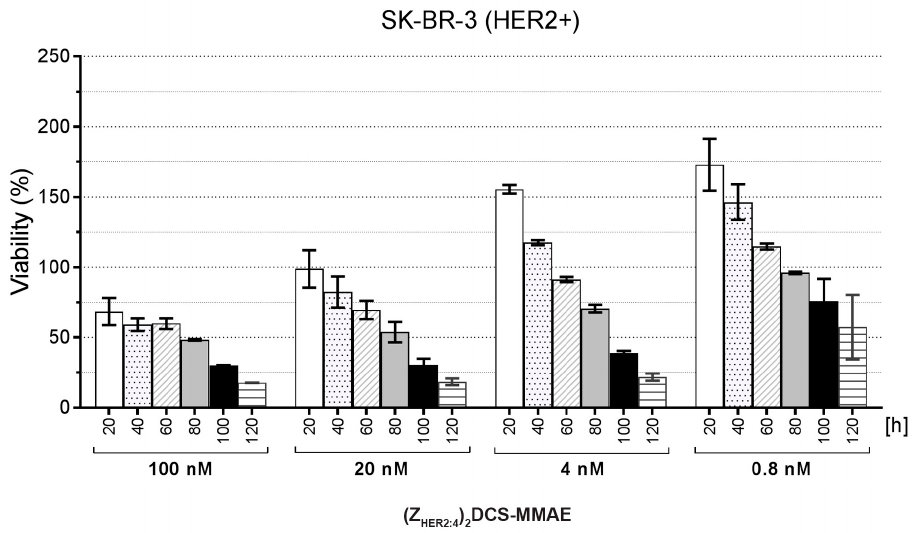
Figure 8. The xCELLigence experiment performed on SK-BR-3 cells treated with (Z HER2:4 ) 2 DCS-MMAE. Results are shown for the selected time points of 20, 40, 60, 80, 100, and 120 h. Results were normalized against the control cells treated with PBS at each time point. The error bars show the standard deviation.